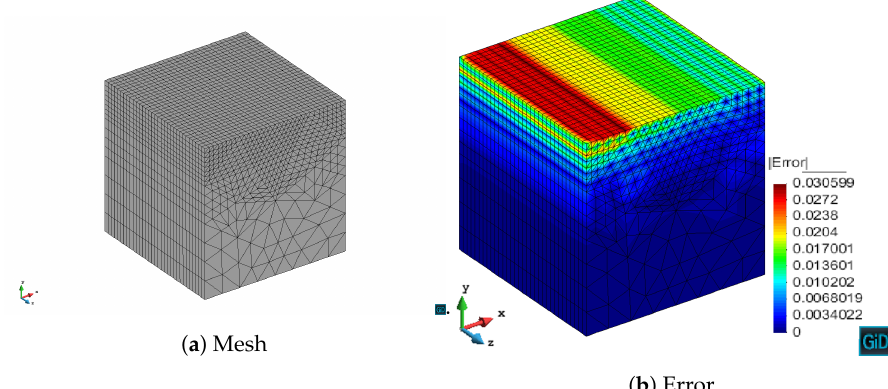
Figure 11. Approximation of (13) using the maximum marking strategy.